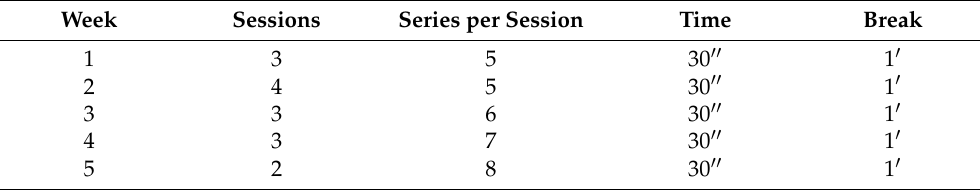
Table 1. Training evolution over the 5 weeks of the experiment, considering the three exercise groups.